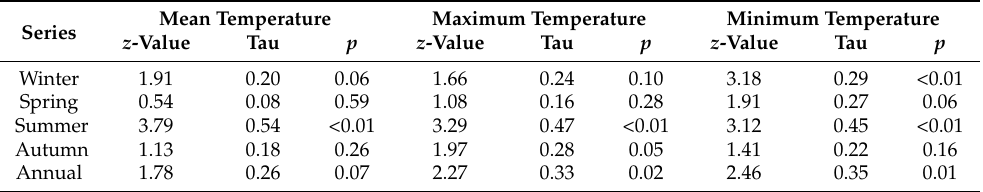
Table 2. Summary of the modified Mann–Kendall statistical tests of temperature trend.